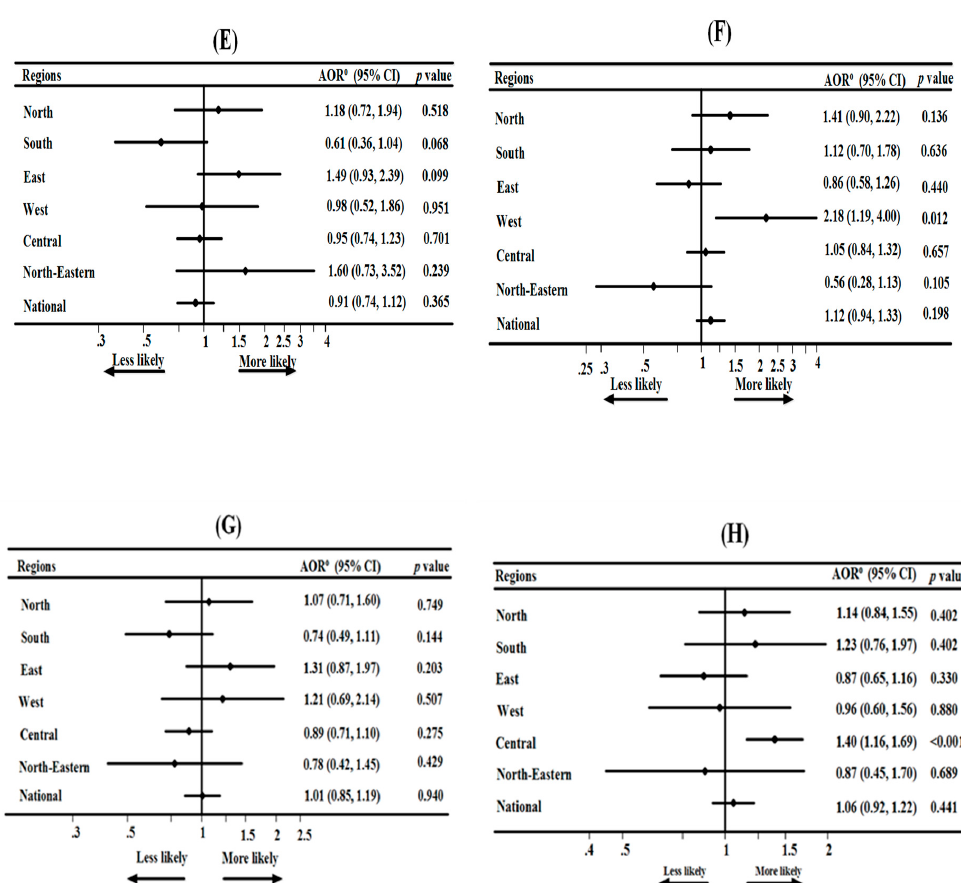
Figure 1. ( A ) Association between early initiation of breastfeeding and diarrhoea in regional India; ( B ) association between exclusive breastfeeding and diarrhoea in regional India; ( C ) association between predominant breastfeeding and diarrhoea in regional India; ( D ) association between bottle feeding and diarrhoea in regional India; ( E ) association between continued breastfeeding at one year and diarrhoea in regional India; ( F ) association between continued breastfeeding at two years and diarrhoea in regional India; ( G ) association between children ever breastfed and diarrhoea in regional India; ( H ) association between introduction of solid, semi-solid or soft foods and diarrhoea in regional India; 95% CI = 95% confidence interval; AOR = adjusted odds ratio; models adjusted for child, maternal, family, media, health service, environmental and community-level factors.